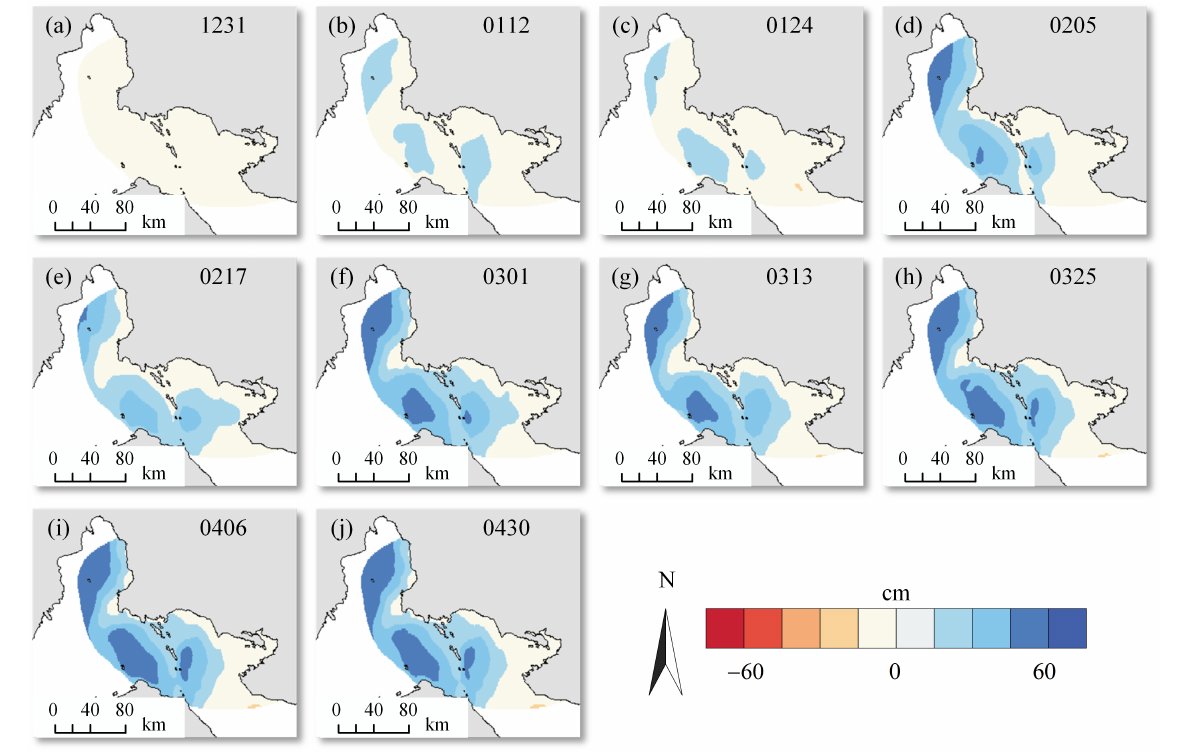
Figure A7. Time-series LOS deformation retrieved from the 2019 descending images: the top-right number of subfigures ( a – j ) represents the corresponding SAR images acquisition dates.